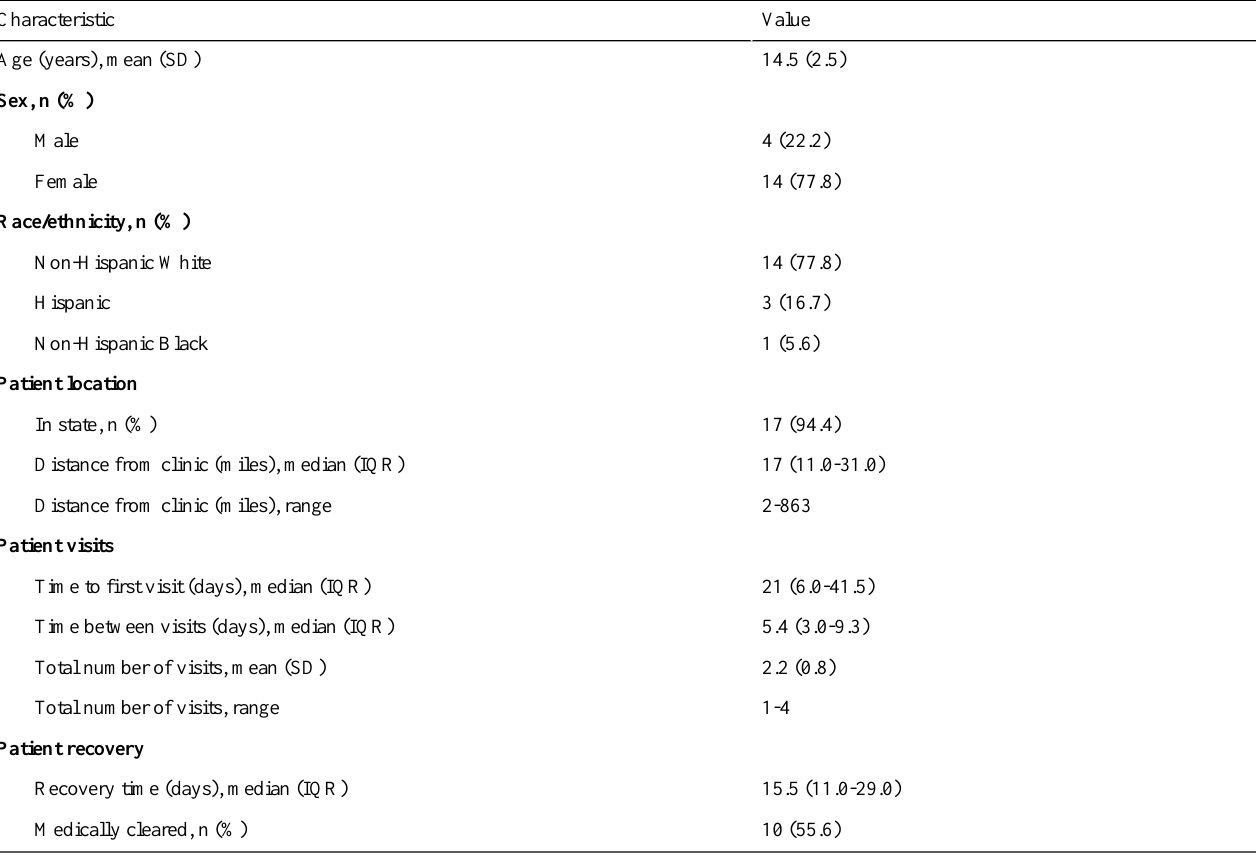
Table 1. Descriptive statistics on patients using a pediatric tele-concussion clinic, 2019-2020 (N=18).